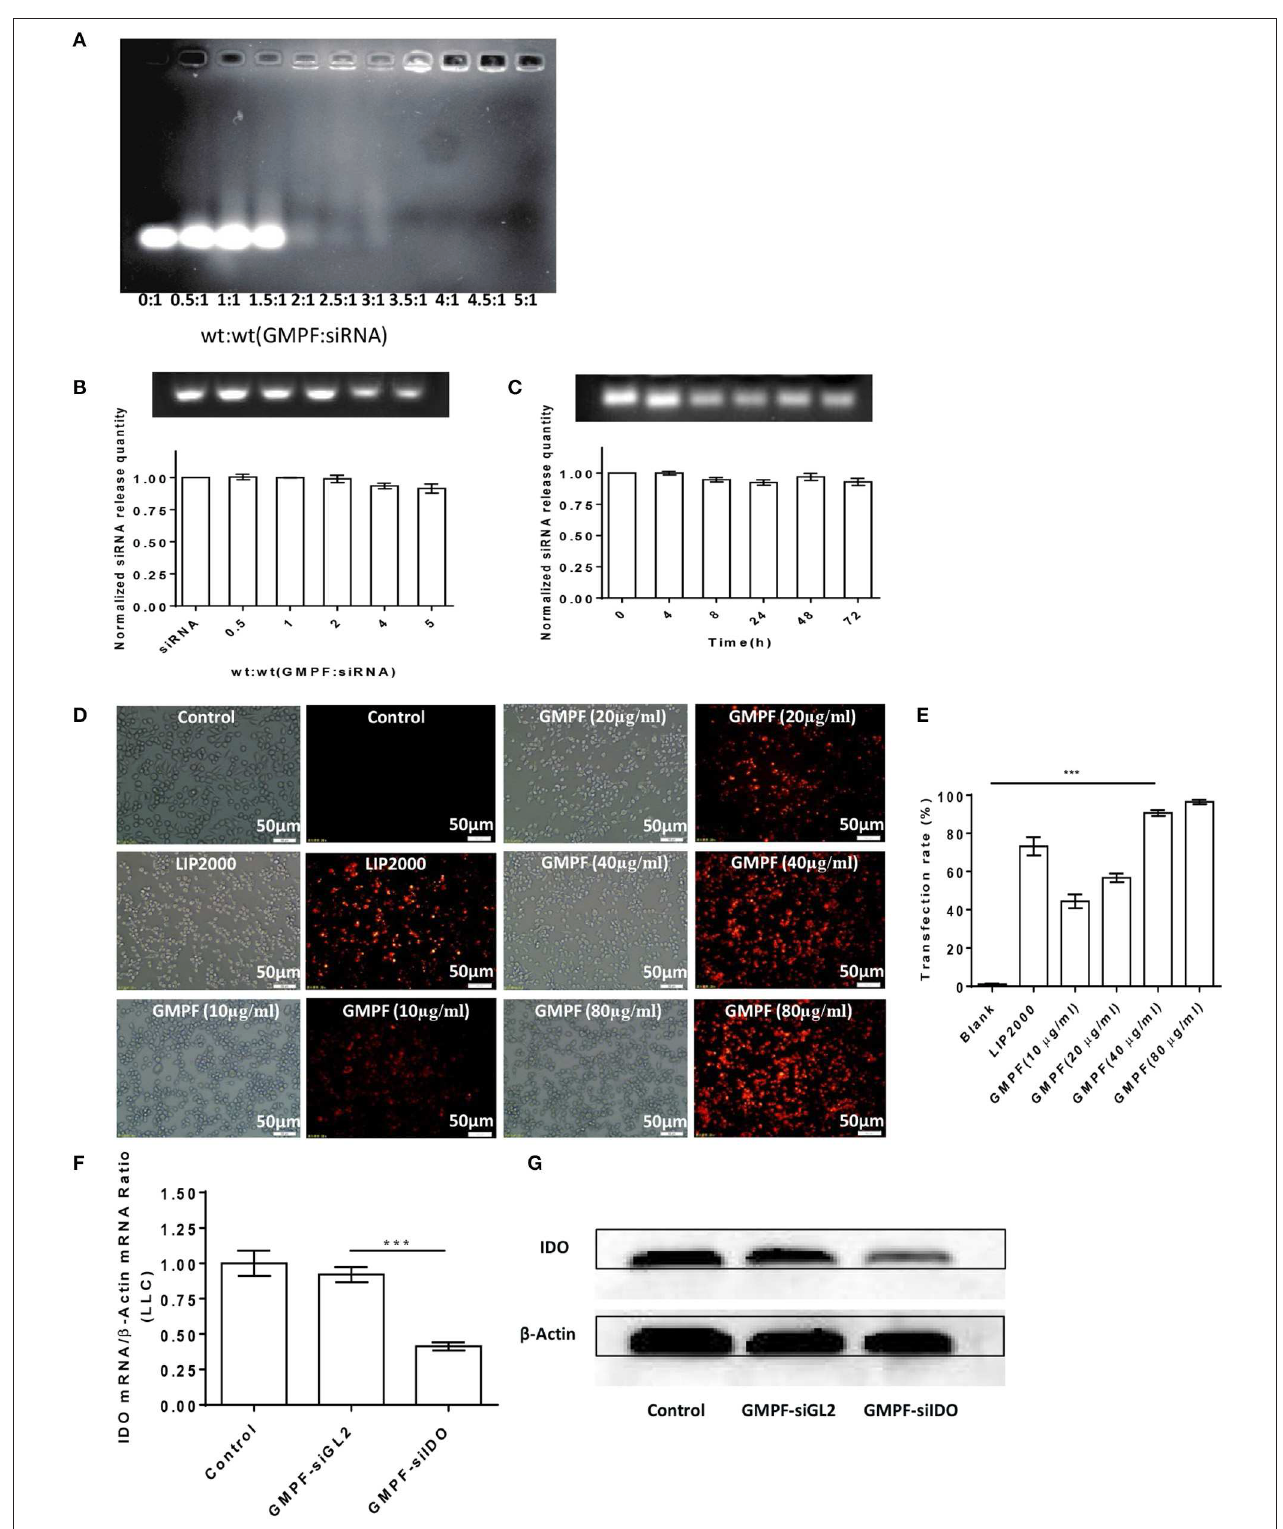
FIGURE 2 | Bio-characterization of GMPF-siIDO. (A) Gel shift assays were used to determine the siRNA-loading capacity of GMPF. Equal volumes containing 0.6 µ g of siRNA and the desired amount of GMPF were incubated at the indicated weight ratios for 30min, run on agarose gels, and visualized with ethidium bromide. (B) Determination of siRNA release from GMPF-siIDO using SDS analysis. Various ratios of GMPF to siRNA [wt(siRNA) = 0.6 µ g] were prepared and all the samples were